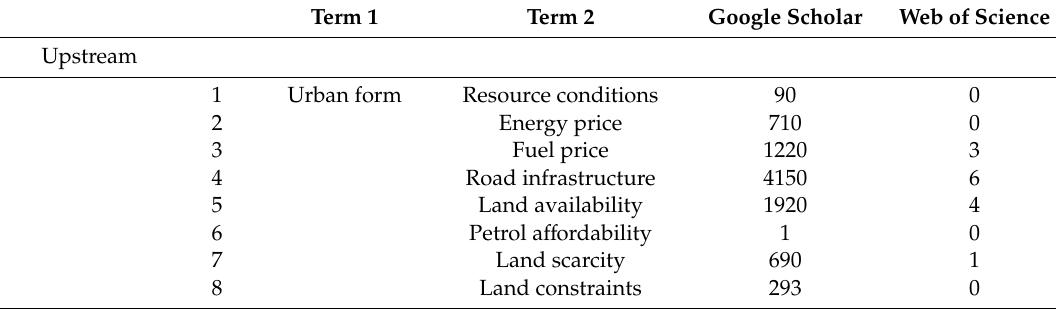
Table A2. Quantitative review of academic urban form literature in relation to resource conditions and implications—results